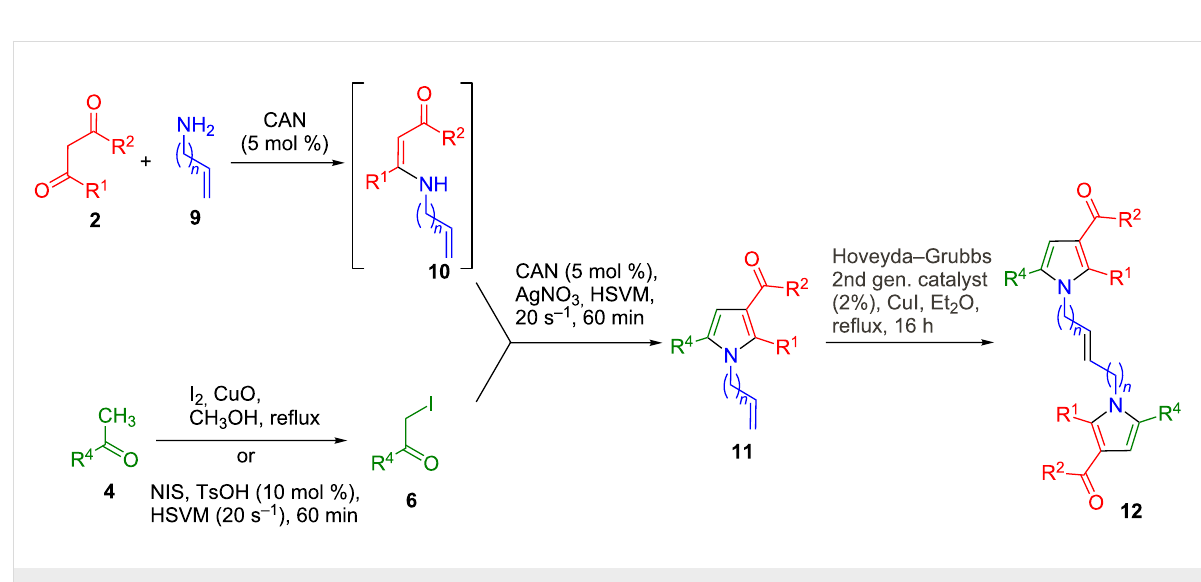
Scheme 4: Homodimerization of 2-allyl- and 2-homoallylpyrroles via cross-metathesis